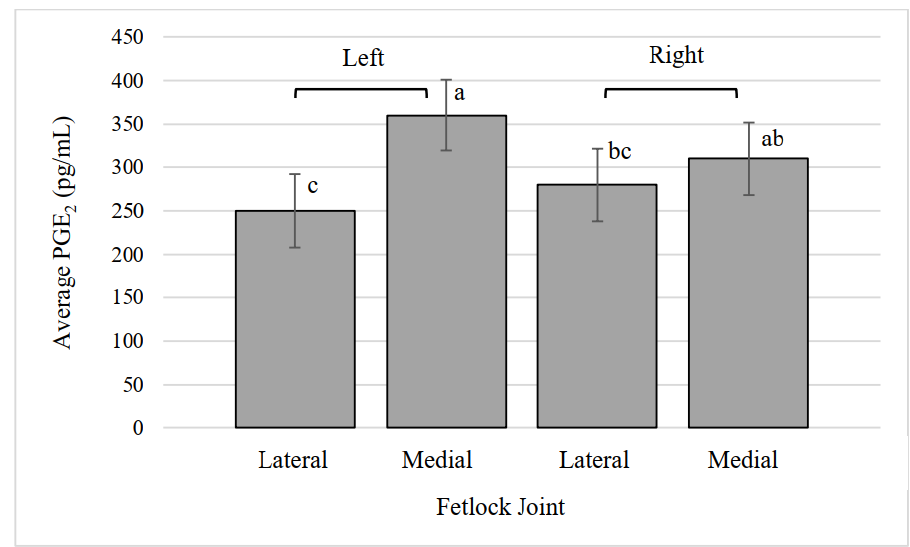
Figure 6. Average prostaglandin E 2 (PGE 2 ) concentration in lateral and medial fetlock joints. a,b,c Values that lack common superscripts differ ( p = 0.0004).